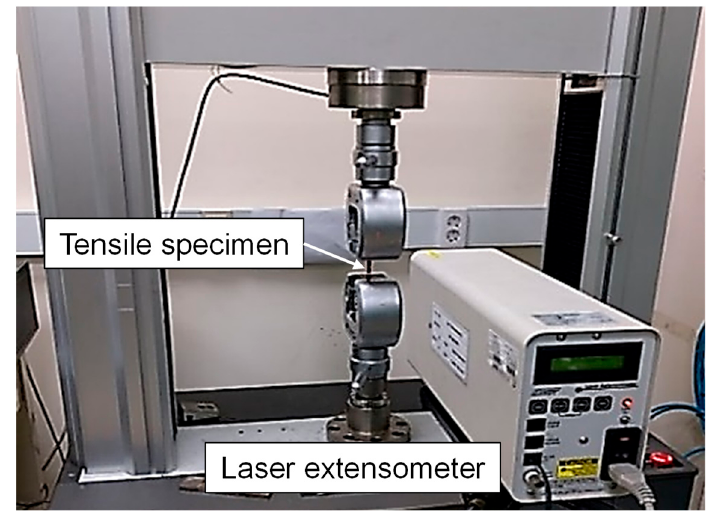
Figure 3. Experimental setup of the uniaxial tensile testing.